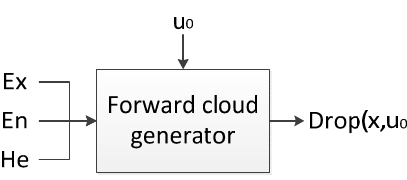
Figure 9. Flow chart of forward cloud generator.